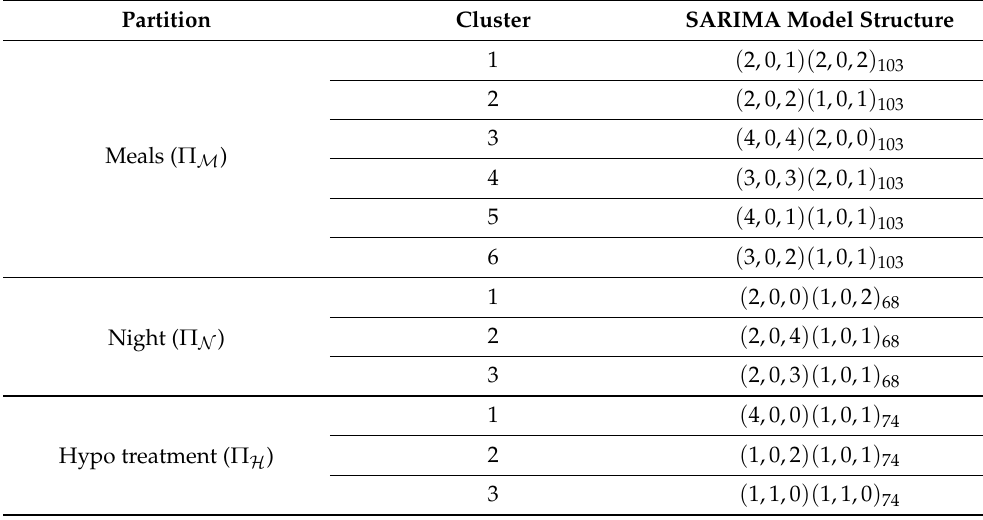
Table 3. Example of local models structure (patient 6), represented as ( p , d , q )( P , D , Q ) s . Partition Cluster SARIMA Model Structure